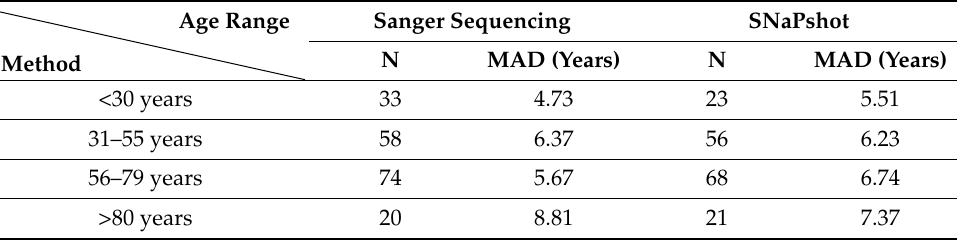
Table 3. Evaluation of mean absolute deviation (MAD) between chronological and predicted ages according to four age-range groups in the training set of blood, bone and tooth samples using both